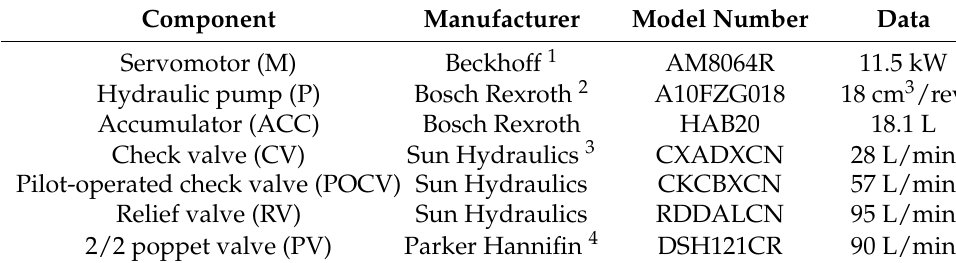
Figure 8. Novel closed-loop electro-hydrostatic actuator circuit. Table 5. Components of the hydraulic system shown in Figure